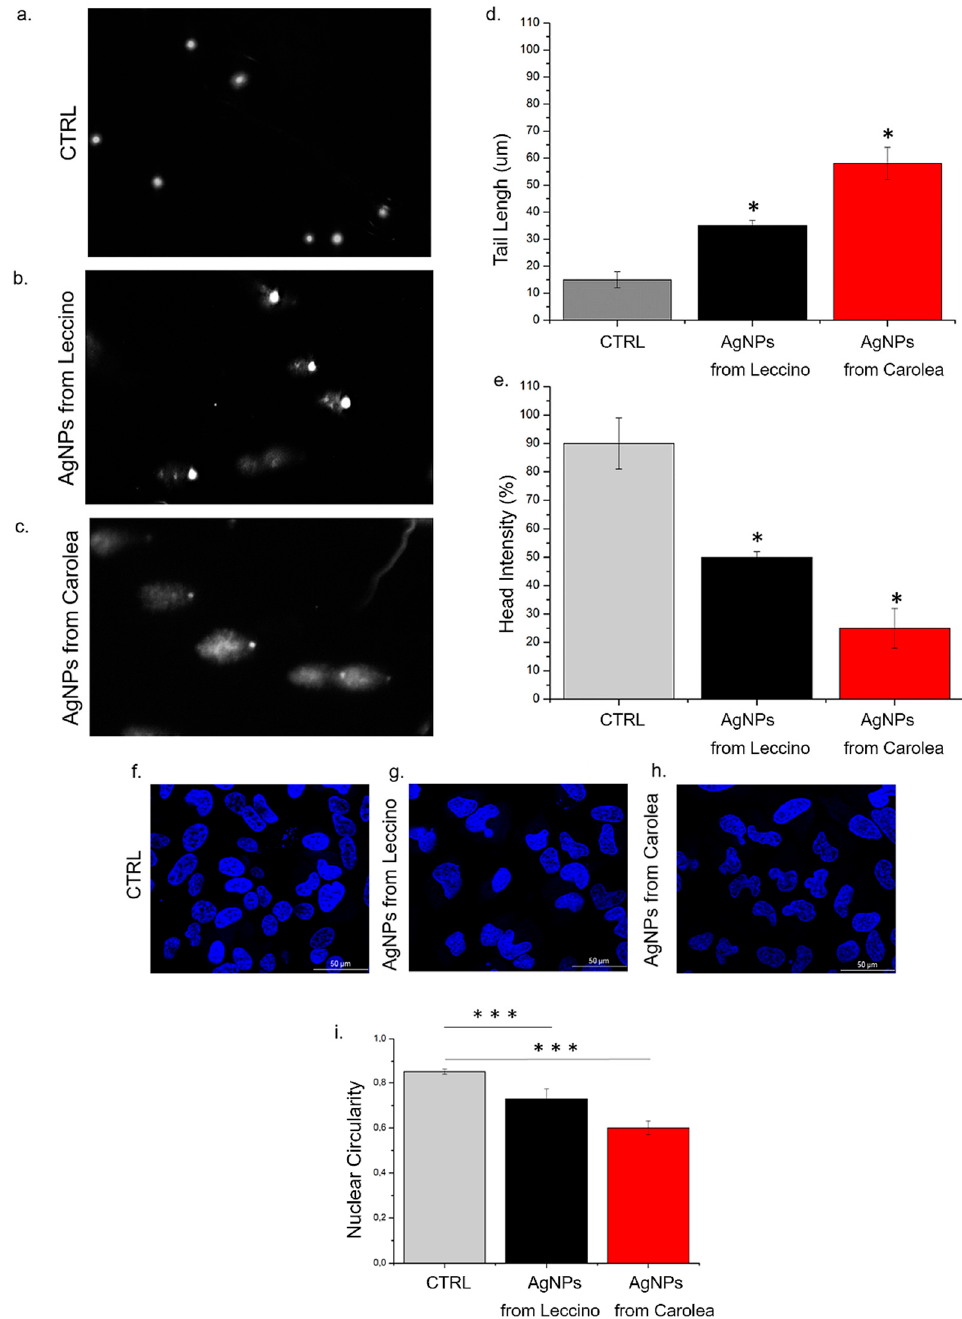
Figure 10. ( a – c ). Representative images acquired by Nikon Eclipse Ti fluorescence microscope of AgNPs (derived from Leccino and Carolea ) effect on DNA damage in HeLa cells line. HeLa were treated with NPs (50 μ g/ml) for 96 h. DNA damage was evaluated by ( d ) tail length ( μ m) and ( e ) head intensity (%). Values shown are means from 100 randomly selected comet images of each sample. As a positive control (P) cells were incubated with 500 μ M H 2 O 2 (data not shown). Data are reported as mean ±SD from three independent experiments; * p < 0.05 compared with control ( n = 3). ( f – h ). Representative confocal images of HeLa nuclei: control ( f ) and after the exposure to 50 μ g/ml of AgNPs from Leccino ( g ) and Carolea ( h ) after 96 h. (i) Histogram reported the mean values and their respective standard deviation of nuclear circularity. The statistical significance of results respect to control cells was evaluated by t test, and reported in histograms (*** p < 0.005.).